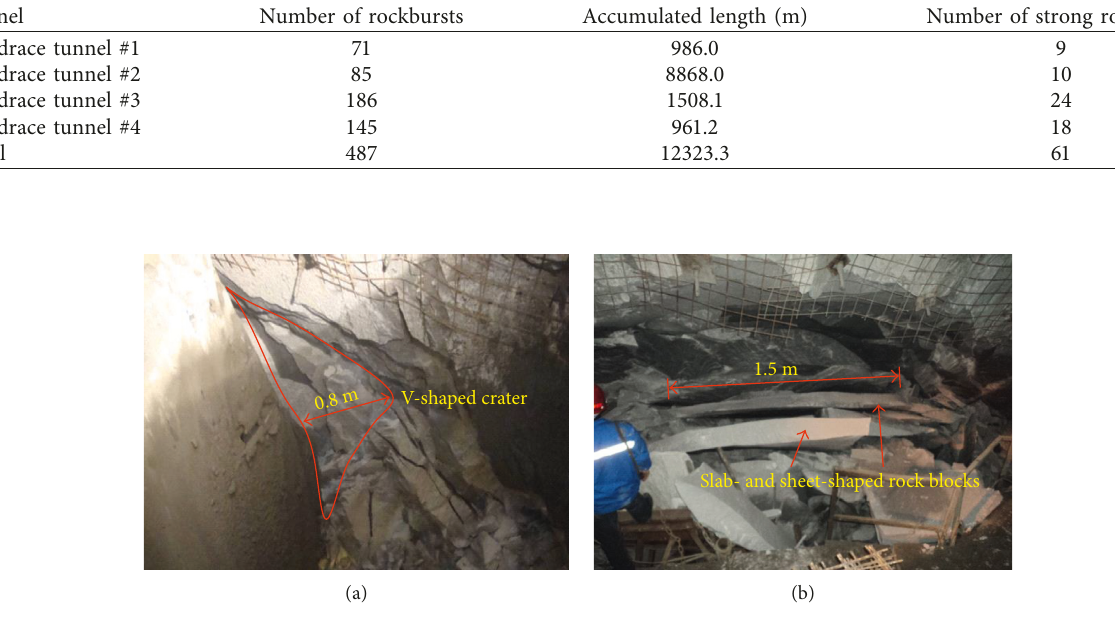
Figure 4: On-site photos of rock failures caused by rockbursts. (a) V-shaped crater caused by a rockburst. (b) Slab- and sheet-shaped rock blocks ejected from the wall in the drainage